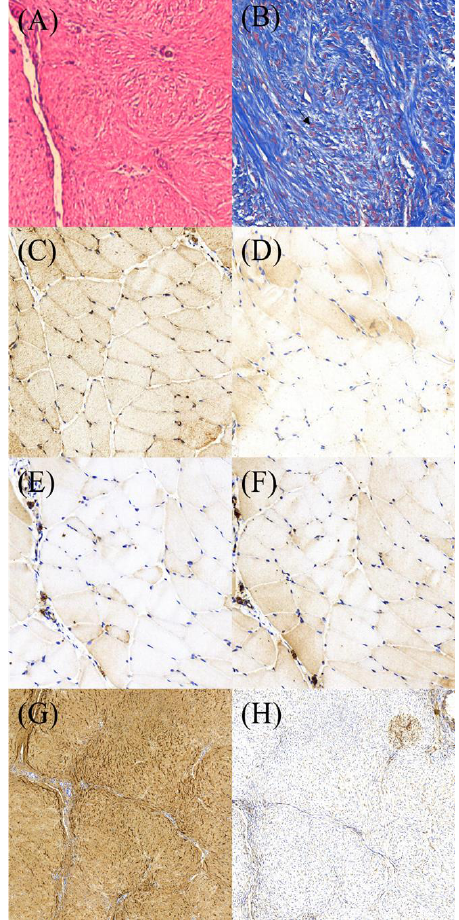
Figure 11. Photos of histology and IHC stain of the specimens from repaired tendons. ( A ) H&E stain (400 × ). ( B ) tenocytes (arrow) by Masson’s trichrome stain (400 × ). IHC stain for growth factors (800 × ): ( C ) VEGF, ( D ) BMP-2. ( E ) TGF-B, and ( F ) vWF. ( G ) and ( H ) showing collagen I and collagen III under IHC stain (400 ×